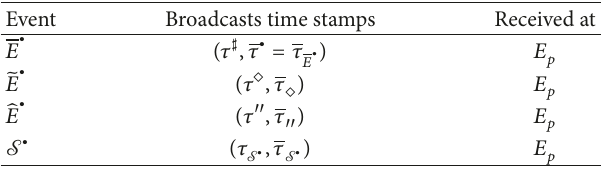
Table 8: The secondary/ancillary events and their broadcast time stamps in the E ch system.